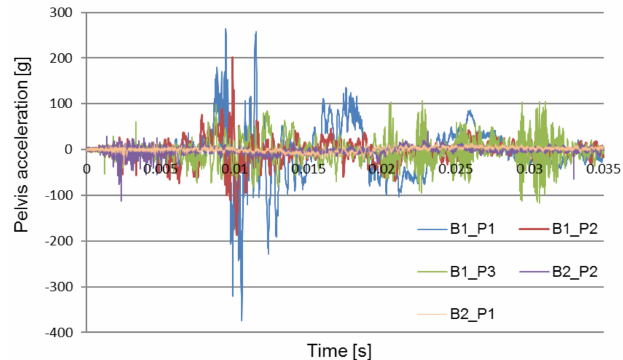
Figure 11. Comparison of pelvic acceleration signals recorded during the tests at the training grounds in ˙Zaga´n (B1) and ´Swi˛etosz ó w